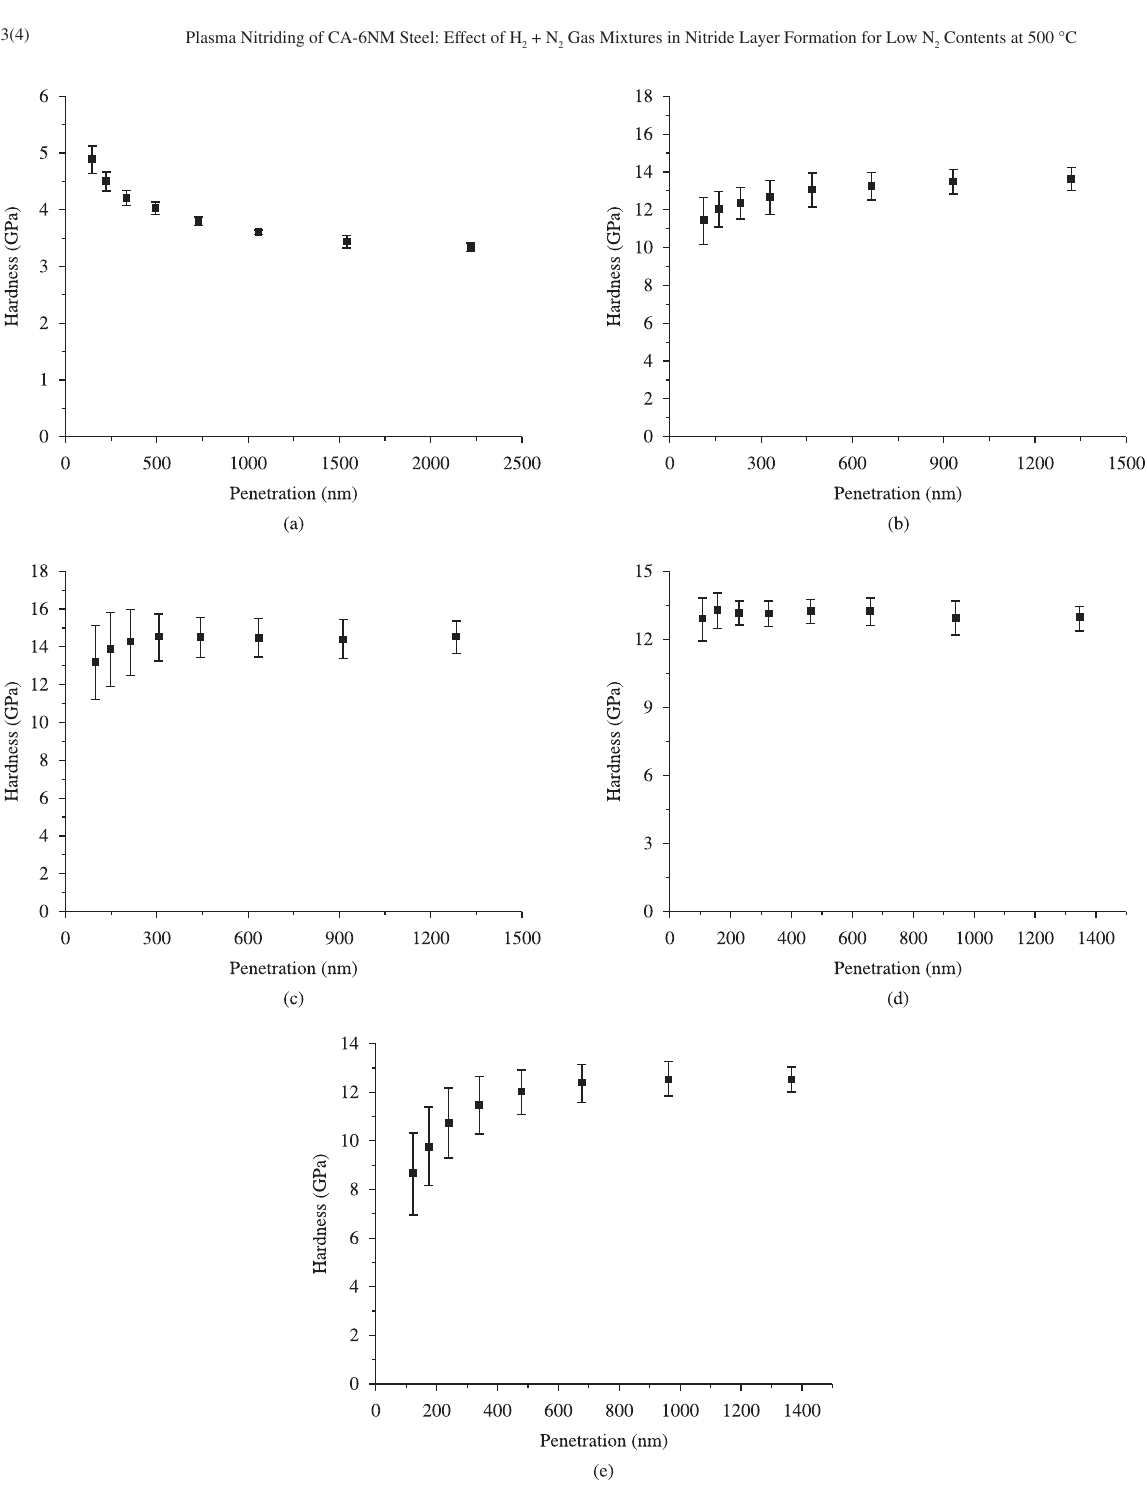
– 2 hours; c) 10% N 2